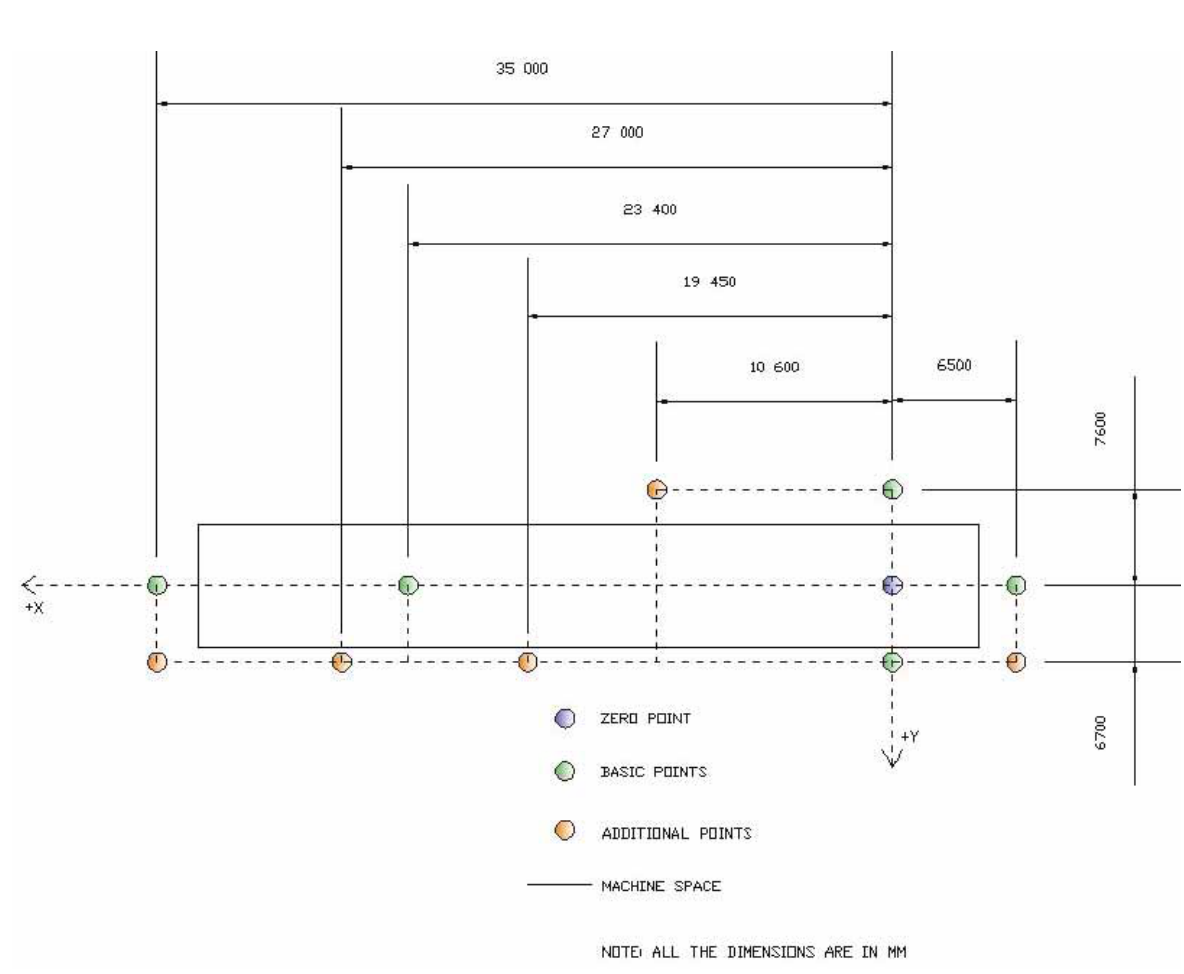
Fig. 1. Scheme of the micro-network points with